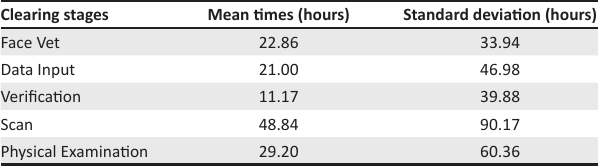
TABLE 2: Time release study, Lagos Apapa Port. Clearing stages